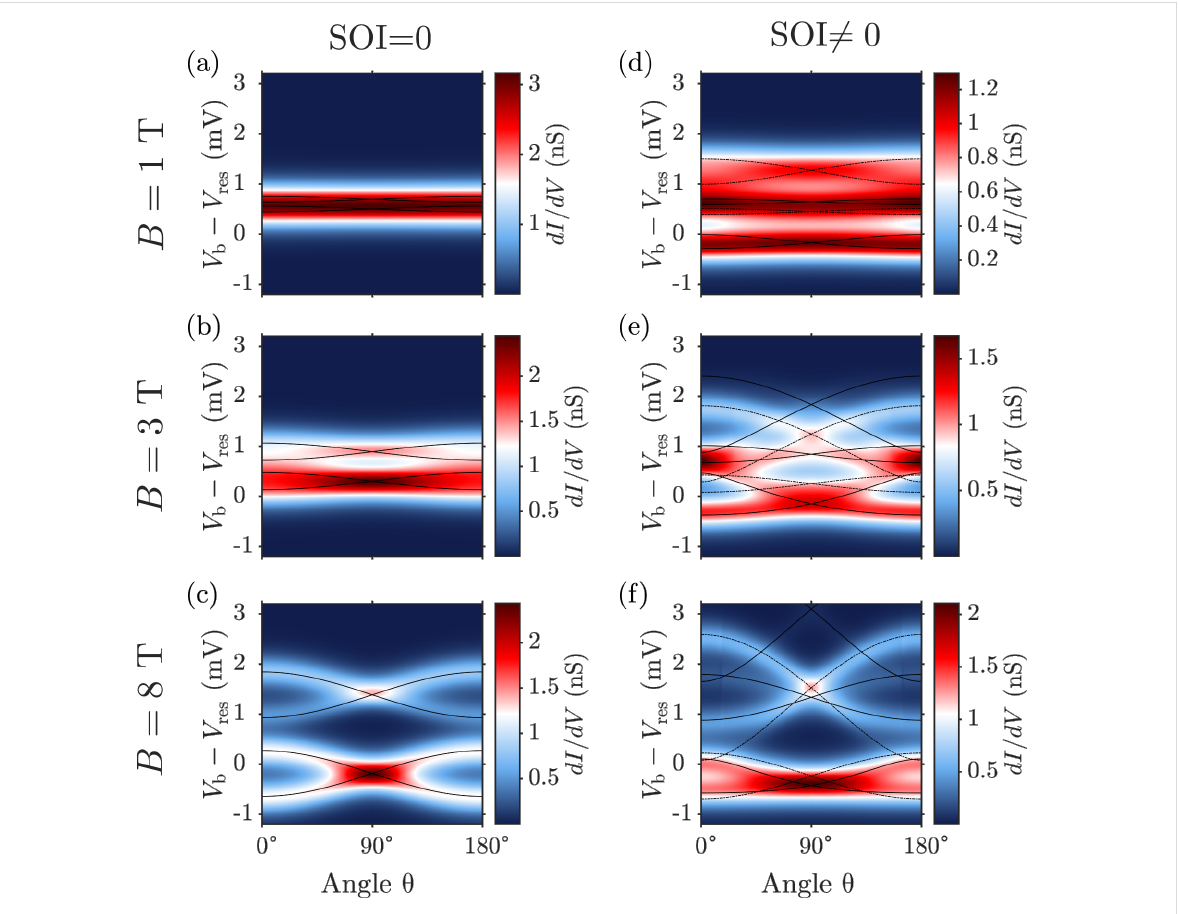
Figure 6: Differential conductance maps vs the angle θ , formed by the applied magnetic field with the z -axis. Left (right) panels are without (with) SOI. Upper, middle and lower panels are calculated for a magnetic field strength of 1, 3 and 8 T, respectively. Solid and dashed lines depict the addition spectrum as calculated from the effective spin Hamiltonian, cf. Equation 28. Transitions starting from the neutral groundstate are denoted by solid lines, those from the neutral excited state by dashed